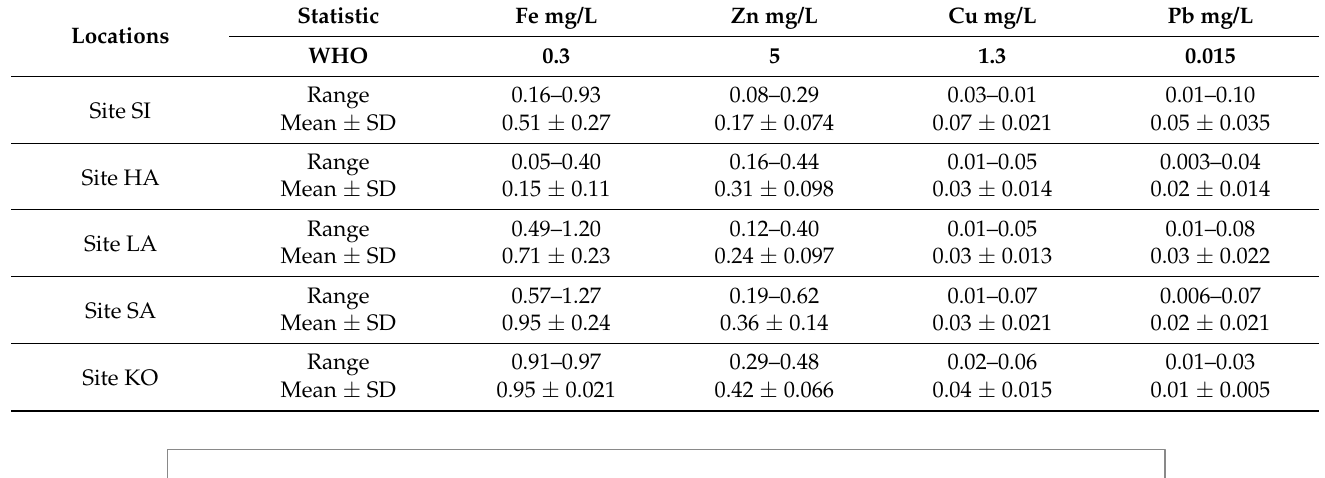
Table 2. Descriptive statistic of heavy metals in roof-harvested rainwater.